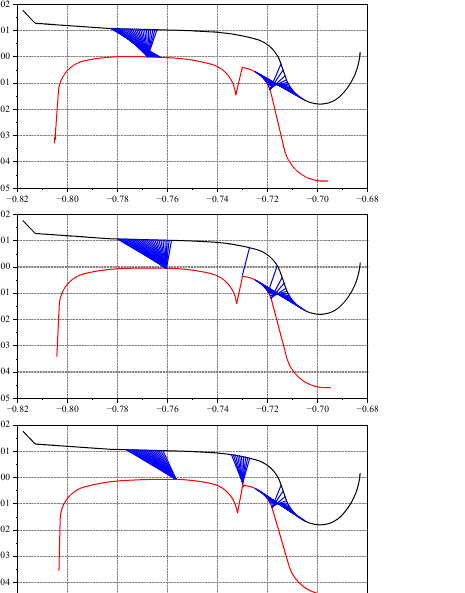
Figure 8. Wheel–rail contact position change of a typical cross-section.